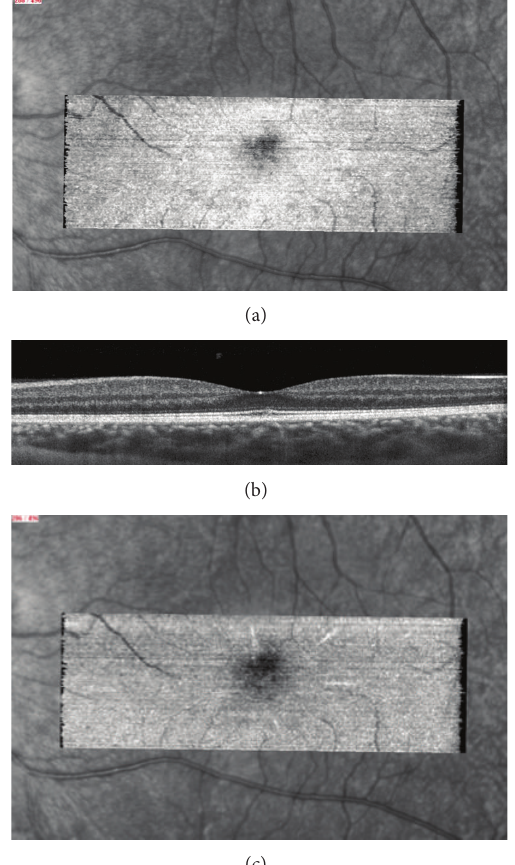
Figure 6: One month later, “en-face OCT” (a) showed an incompletely restored IS/OS line while B-scan (b) seems to be normal. A slight hyperreflective macular star at the ONL level (c) is